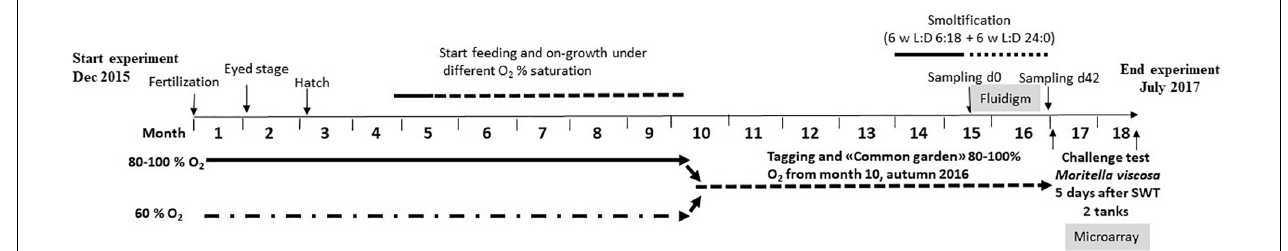
FIGURE 1 | Design of the